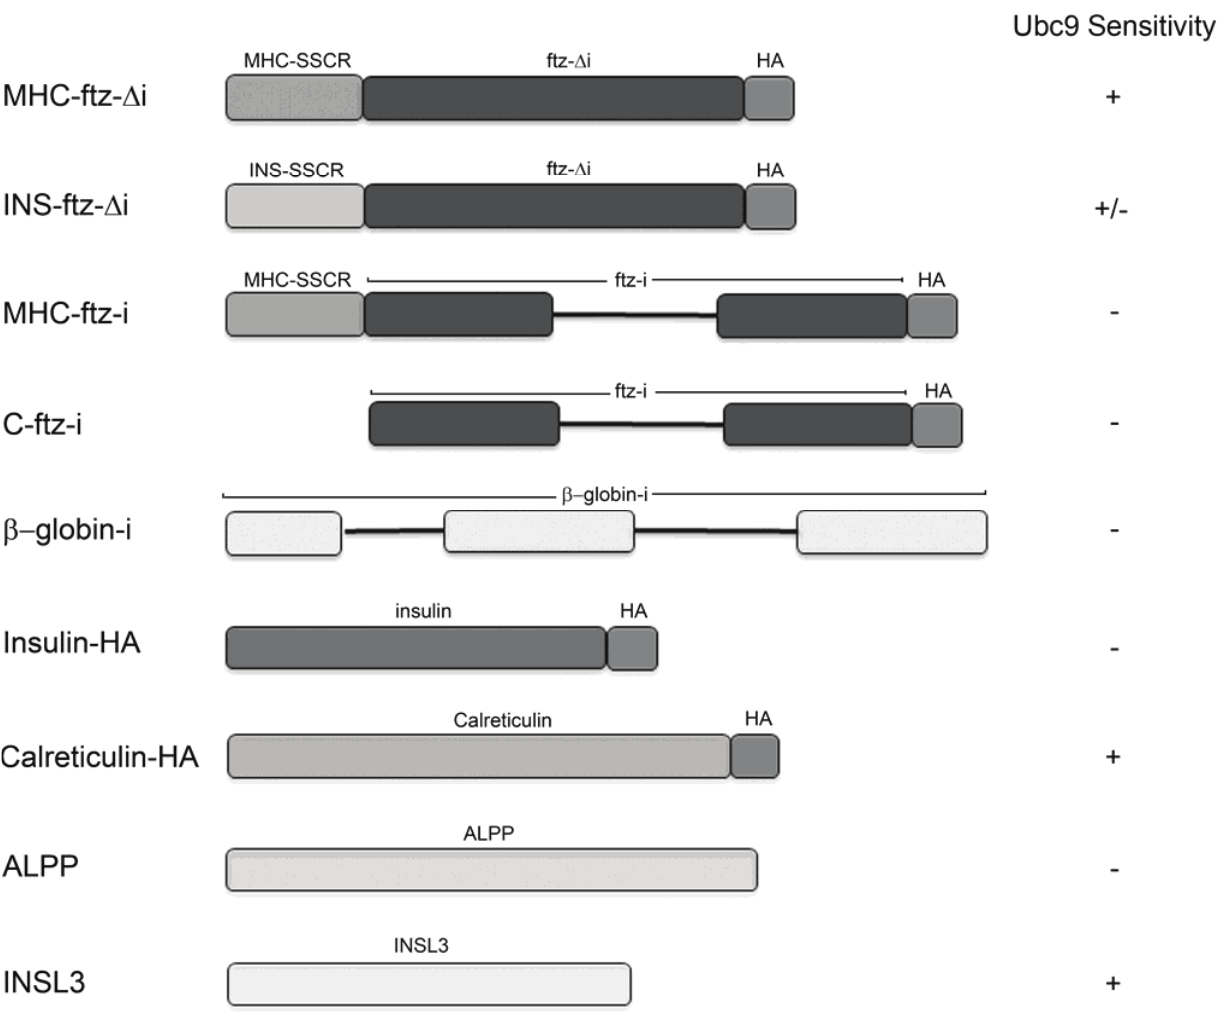
Figure A1. List of model mRNA transcripts used in this study. Note that the ability to accumulate in the cytoplasm in a Ubc9 dependent manner (“Ubc9 Sensitivity”) is indicated on the